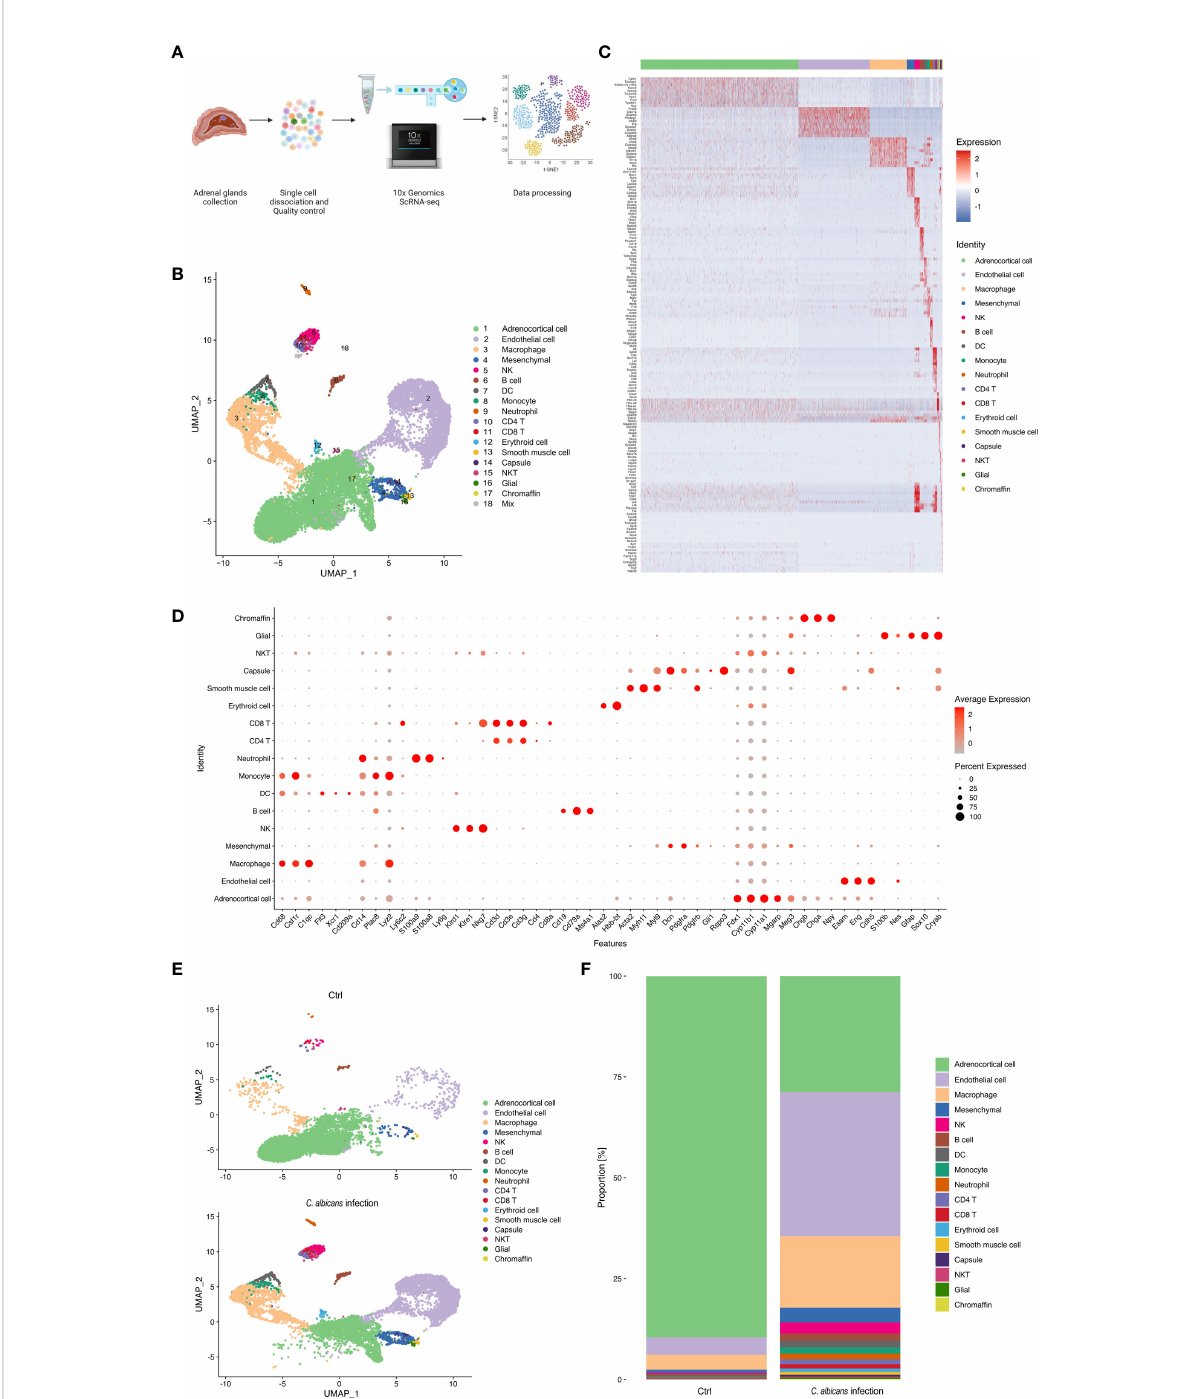
FIGURE 2 Single-cell RNA-seq analysis of the murine adrenal glands following systemic C. albicans . (A) Schematic of the single-cell RNA sequencing (scRNA-seq) work fl ow. (B) UMAP was used to clustering the cells in murine adrenal glands. Samples were pooled from 15 mice per group for analysis. Cell types were determined by using SingleR package based on immgenreference data set and well-established cell type-speci fi c markers. (C) Heatmap showing expression of enriched markers genes for each cell type in scRNA-seq. (D) Bubble plot of the speci fi c marker genes used for annotation of each cell type. (E) UMAP plots showing the cell clusters in the adrenal glands from the infected mice (bottom) and uninfected controls (top). And the proportion of each cell type in each group was shown in (F)